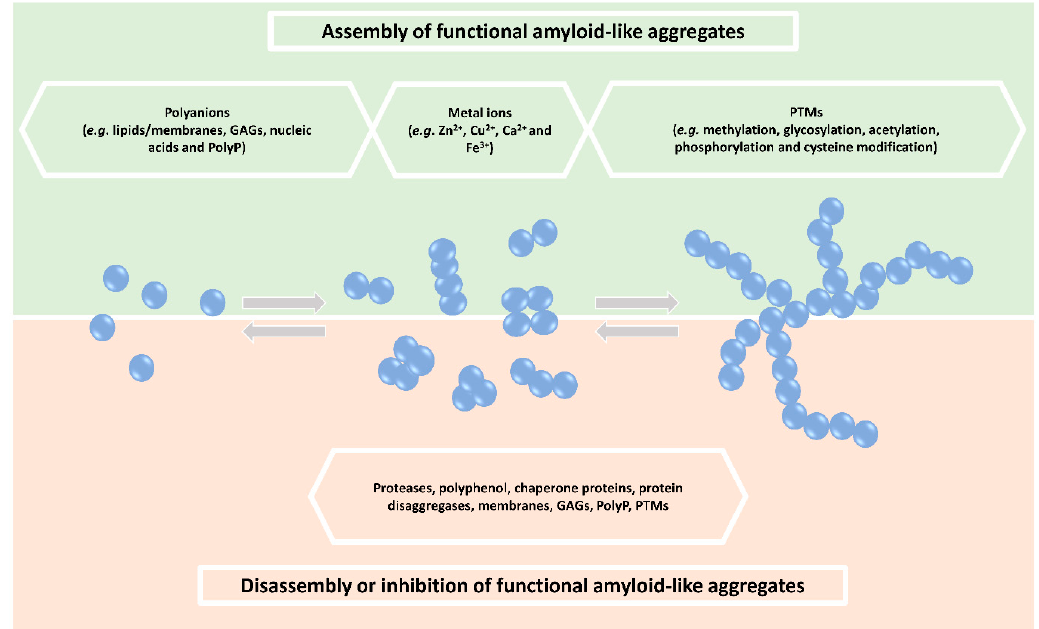
Figure 1. Factors modulating the dynamics of functional amyloid-like aggregates. Factors involved in regulating assembly of functional amyloid-like aggregates (top half) and/or disassembly to inhibit pathological amyloid-like aggregates (bottom half) are indicated in the